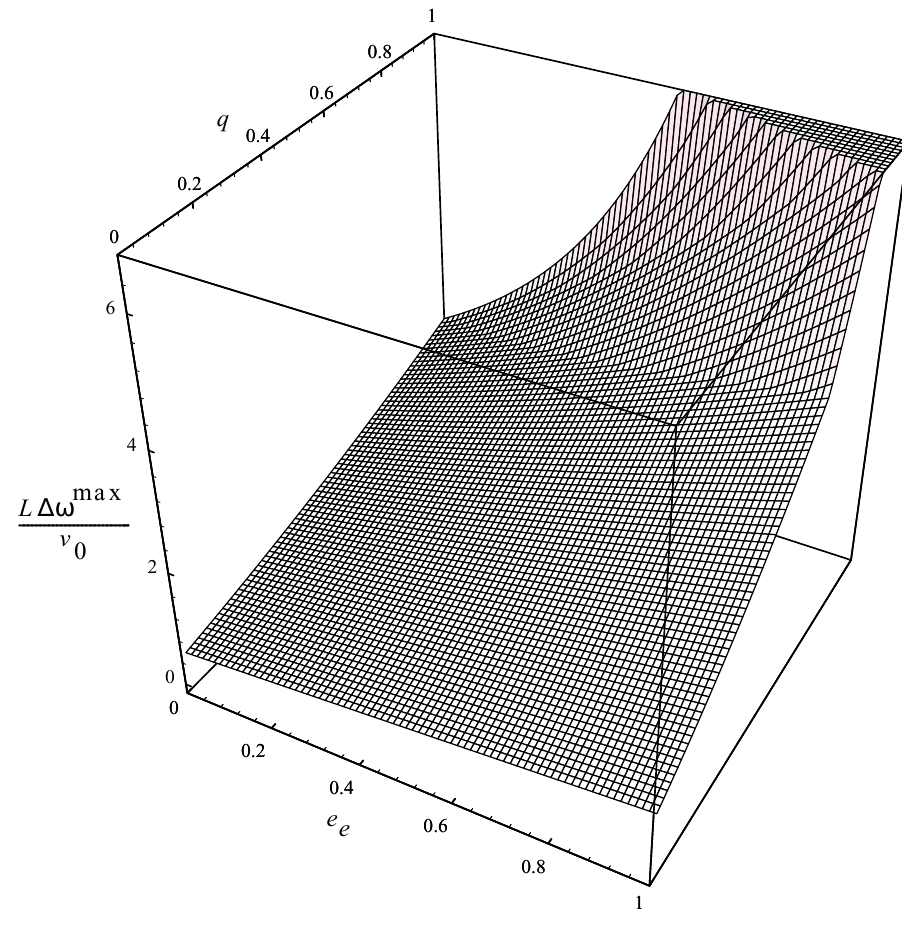
Fig. 3. 3-D surface-plot of the maximum angular velocity change in any one impact ∆ ω max , normalized by v 0 /L . Angular velocity and its changes are the same at all points on the bar. plot for s = 1 is monotonic with increasing q and e e , whereas the plot for s = 0 is (cid:1) 1 ∆ v max . Figure 3 shows the 2 absolute values of the maximum change in angular ve- locities, | ∆ ω max | .